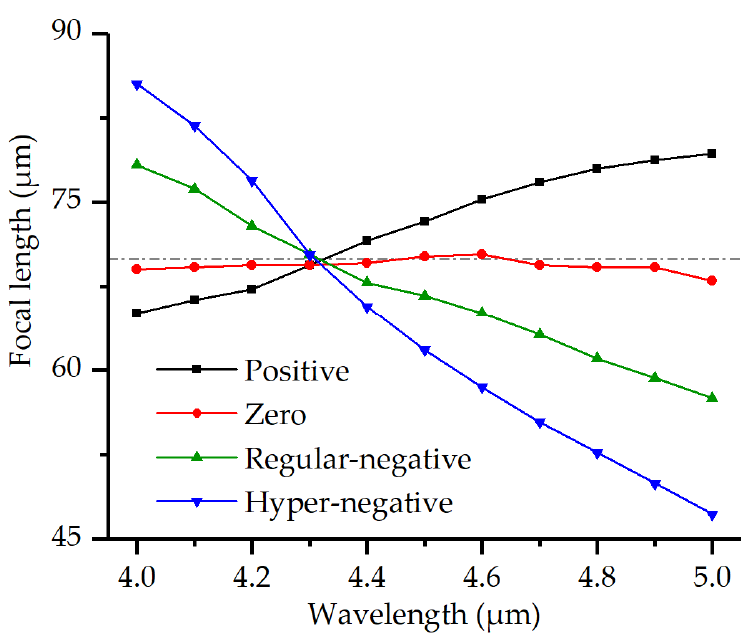
Figure A1. The simulated electric field intensity on the x-z plane for the four FVBGs at 4.3 μ m. The green line indicates 70 μ m.